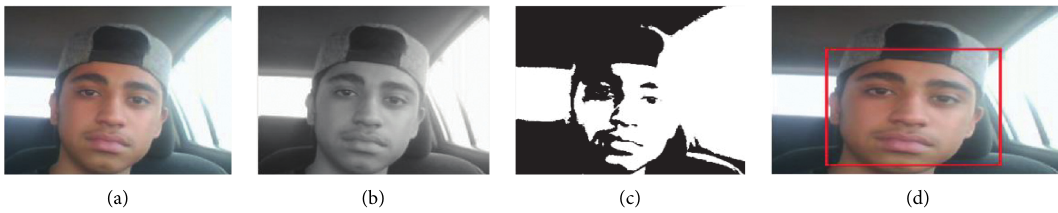
Figure 4: (a) Original image, (b) converted to gray image, (c) converted to binary image, and (d) face